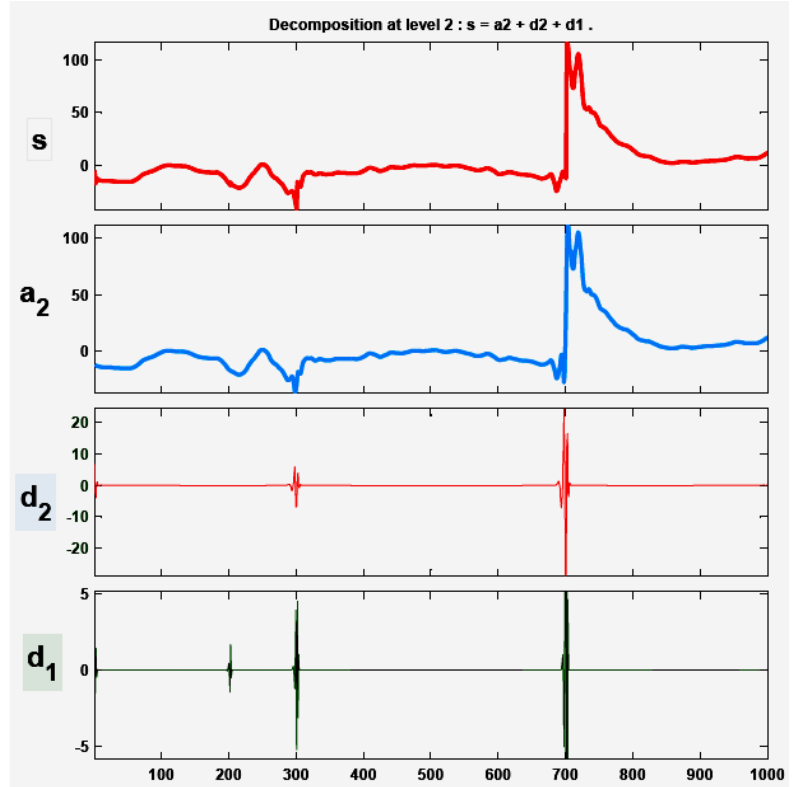
Fig. 7. The decomposition up to level 2 of the de-noised signal s ( t ) of the synthetic composed signal (first derivative of a series of exponential spikes + colored noise). Units of the signal s (approximation a 2 , details d 1 and d 2 ) and the time t are arbitrary.